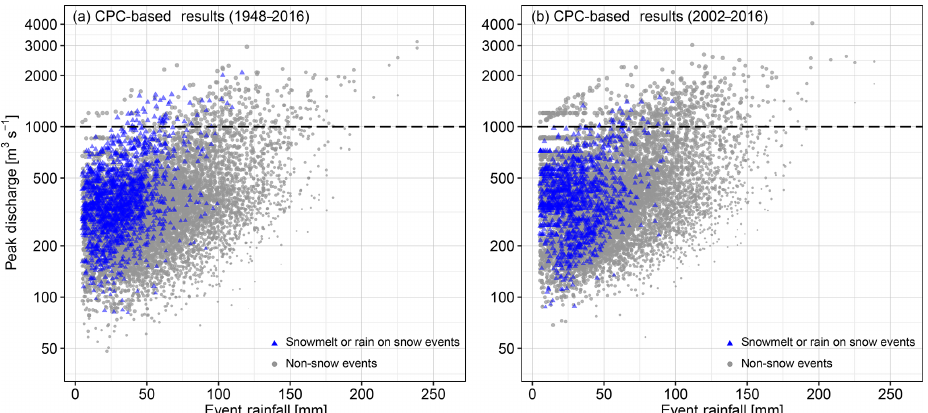
Figure 8. The simulated flood magnitude using CPC rainfall during the 1948–2016 (a) and 2002–2016 (b) periods, and corresponding antecedent conditions. The blue triangles denote the snow-related flood events (e.g., snowmelt was nonzero in the simulation) and grey dots represent the non-snow-related flood events (e.g., rainfall driven). The sizes of the triangles or dots indicate the antecedent soil moisture with a higher value in a larger shape. The black dashed line indicates the 1000m 3 s − 1 flood magnitudes.